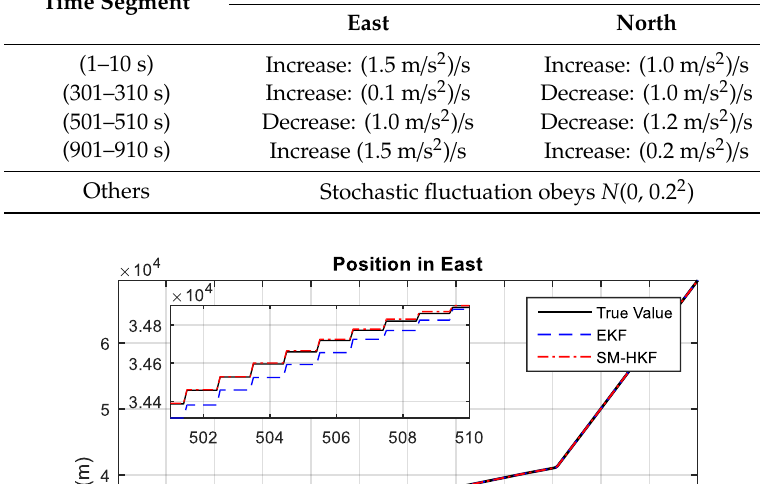
Figure 5. The velocities in East estimated by EKF and SM-HKF from 490 s to 520 s.